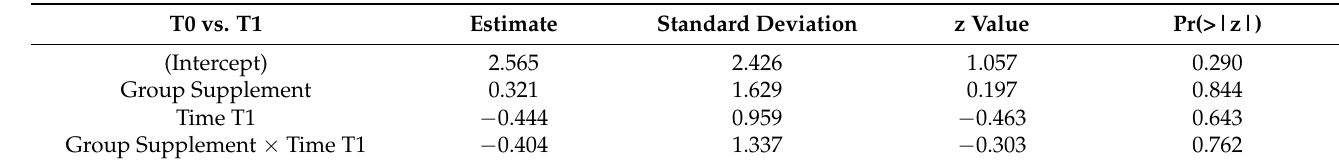
Table 4. Best “Effect” Estimate of Knee Grinding. Fixed effects from multilevel model of knee grinding at times T0 vs. T1.